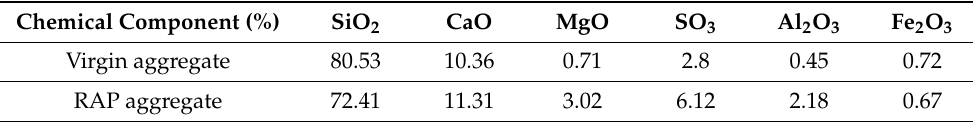
Table 2. The physical properties of the virgin aggregate and RAP.